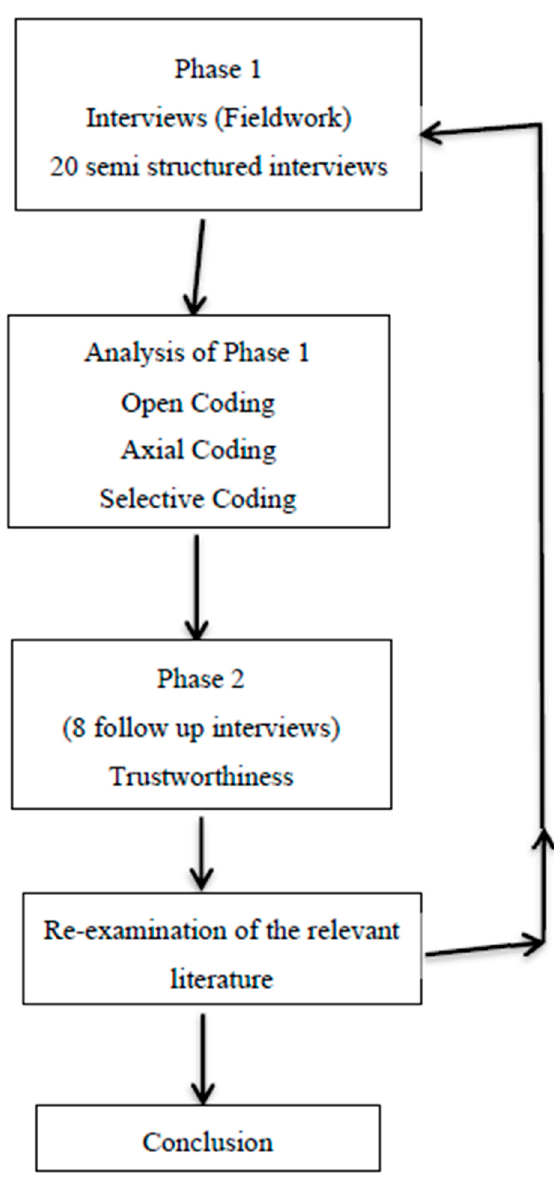
Figure 2. Qualitative research process.